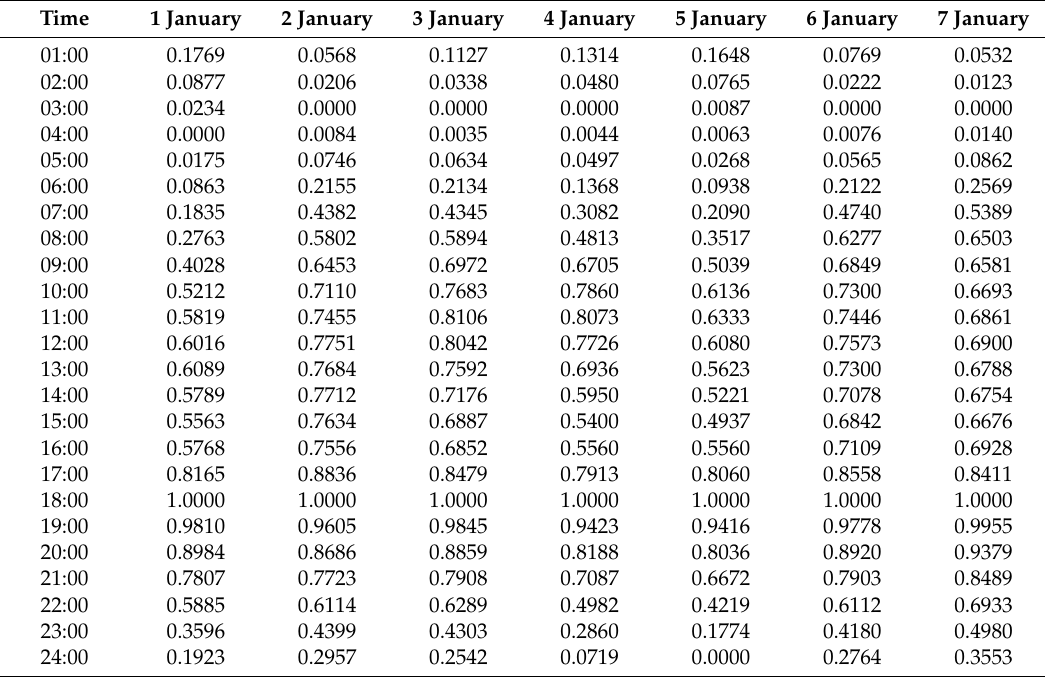
Table 2. Normalization values of load data for GEFCom2014 (Jan.).